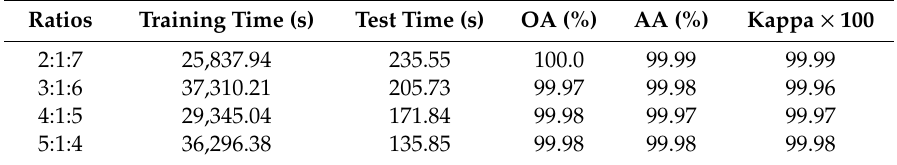
Table 8. Training time, test time, and OA under di ff erent ratios on the UP dataset by the proposed